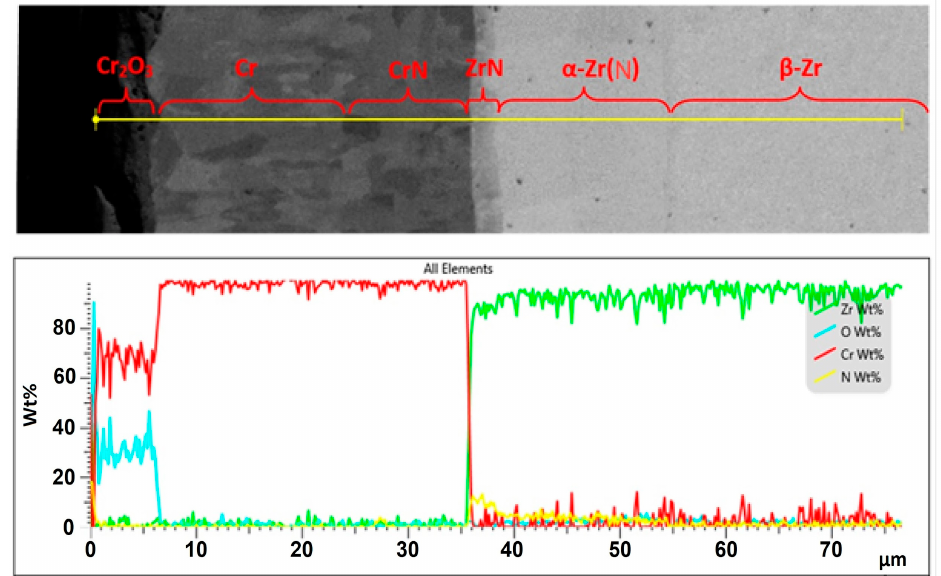
Figure 15. Microstructure of Cr/CrN-coated Zr-1%Nb alloy after HT oxidation in steam at 1365 °C for 2 min: SEM image and corresponding EDS line scan. Reproduced from [183] with permission by Elsevier. Table 3. Comparison of properties of possible barrier layers between Cr-based coatings and zirconium alloys. Zirconium and chromium are presented for comparison.